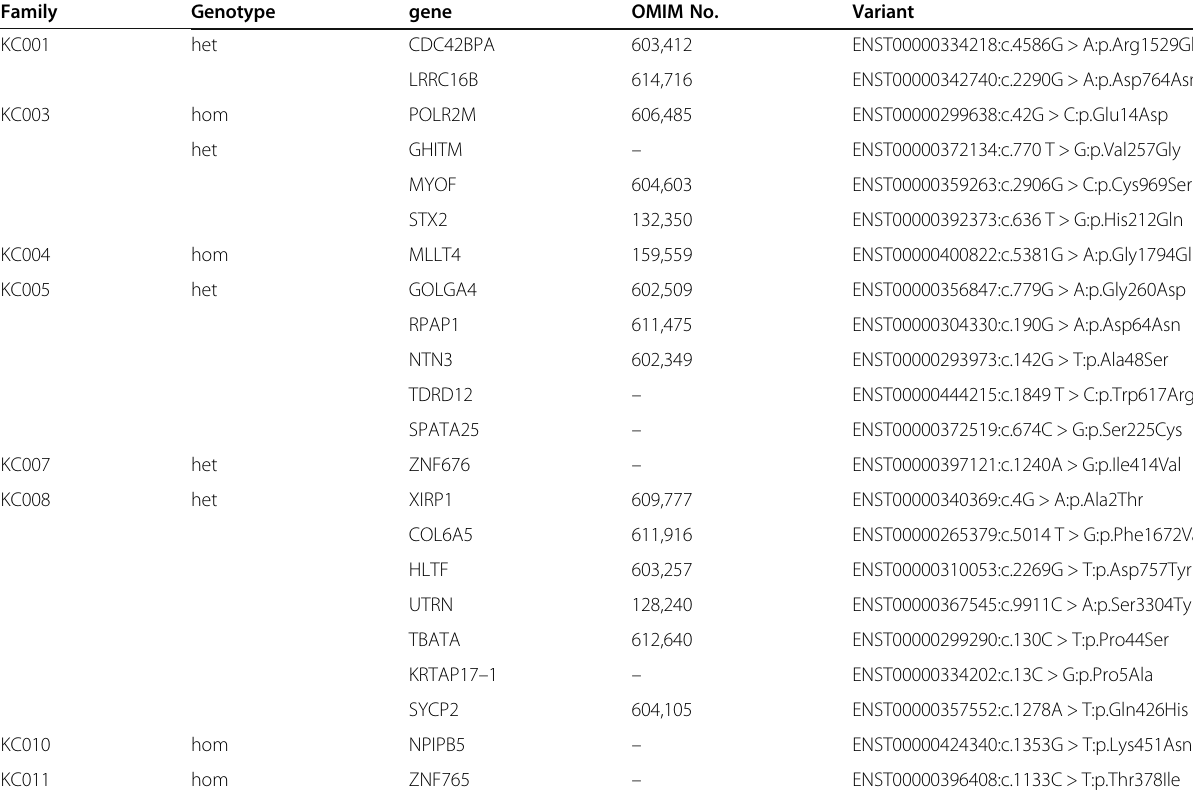
Table 1 Identified variants after the filtration procedure